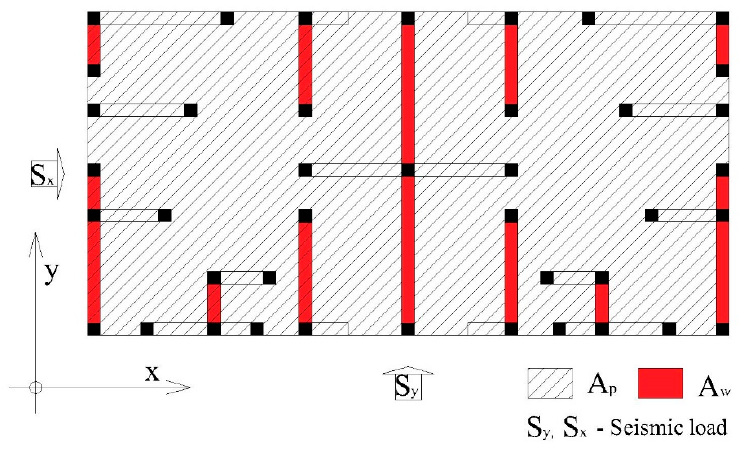
Figure 3. Input parameters for the Wall Index ( WI ) calculation. Table 4. Minimum required WI ( p A,min ) values for URM buildings based on Eurocode 8, Part 1.